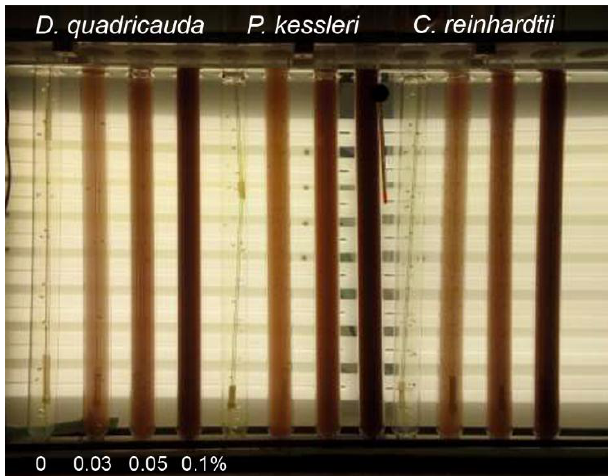
Figure 8. Photobioreactor used for experiments. The photobioreactor consisted of glass cylinders placed in thermostatic water bath illuminated from one side by a panel of dimmable fluorescent lamps. The experimental species cultures were grown either in absence (0%) (control) or in different red mud concentrations (0.03, 0.05, 0.1%).